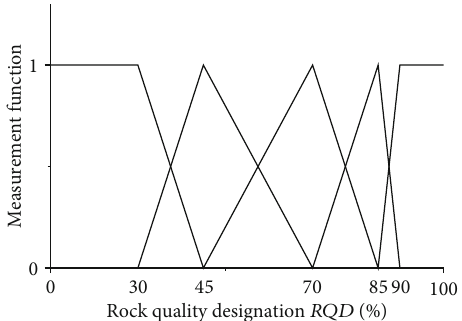
Figure 4: Uncertainty measurement function of rock integrality coe ffi cient.